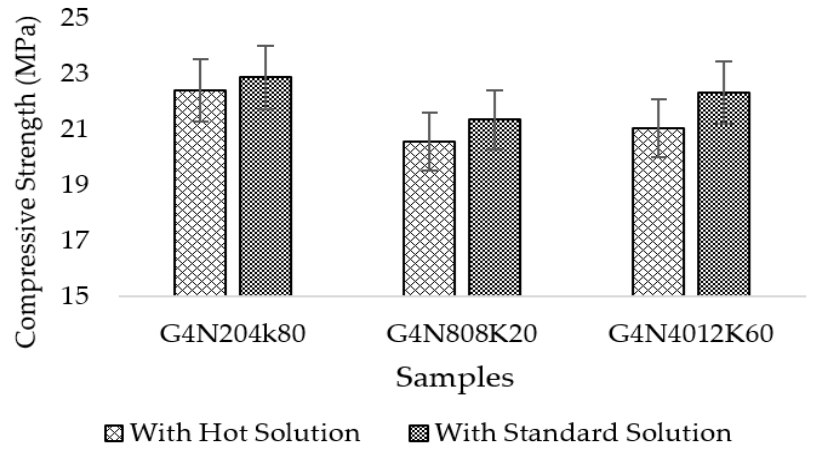
Figure 18. Compressive strength of geopolymer cement paste at 28 days.